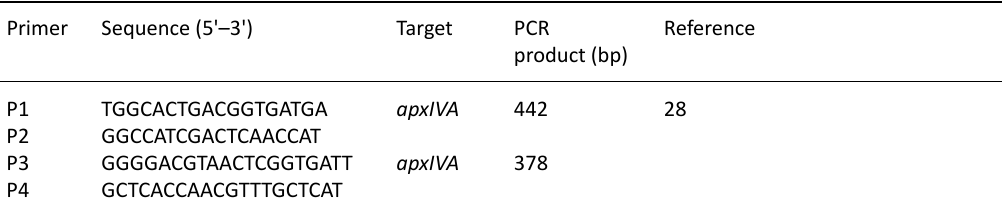
Table 1. Primers used in this study